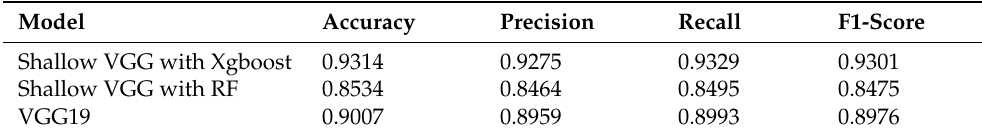
Table 11. Performance evaluation on tomato field images.